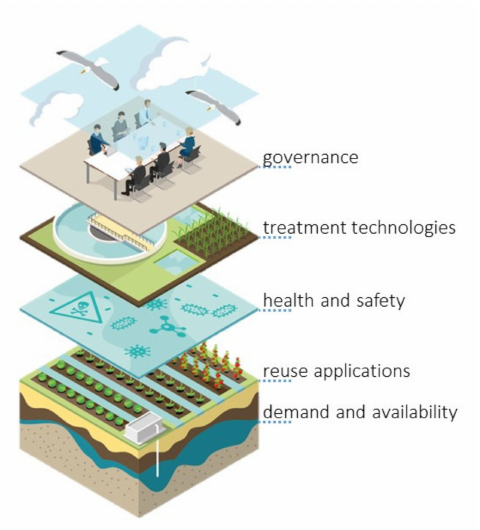
Figure 1. Di ff erent disciplines are needed for the practice of responsible water